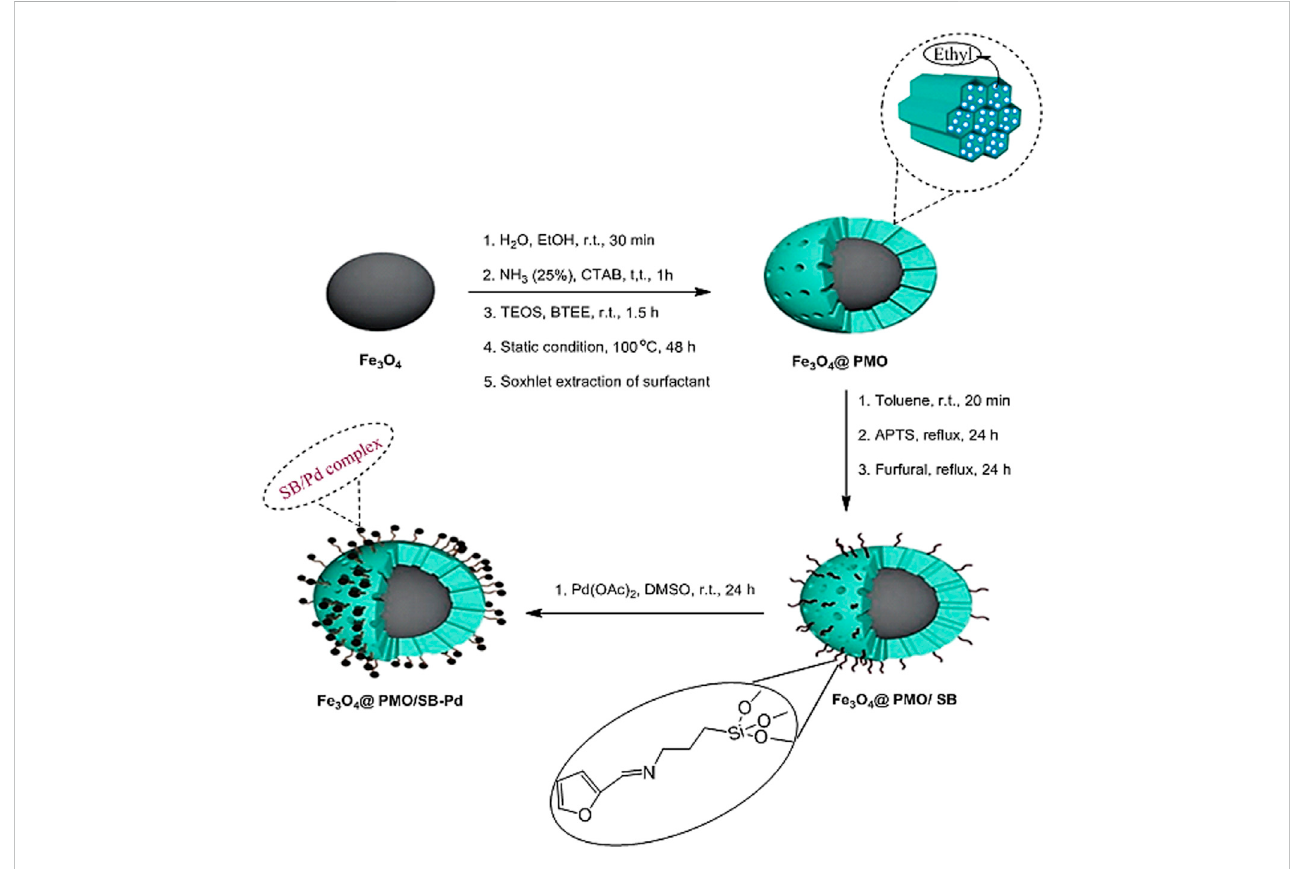
FIGURE 1 Production of Fe 3 O 4 @PMO/SB-Pd.